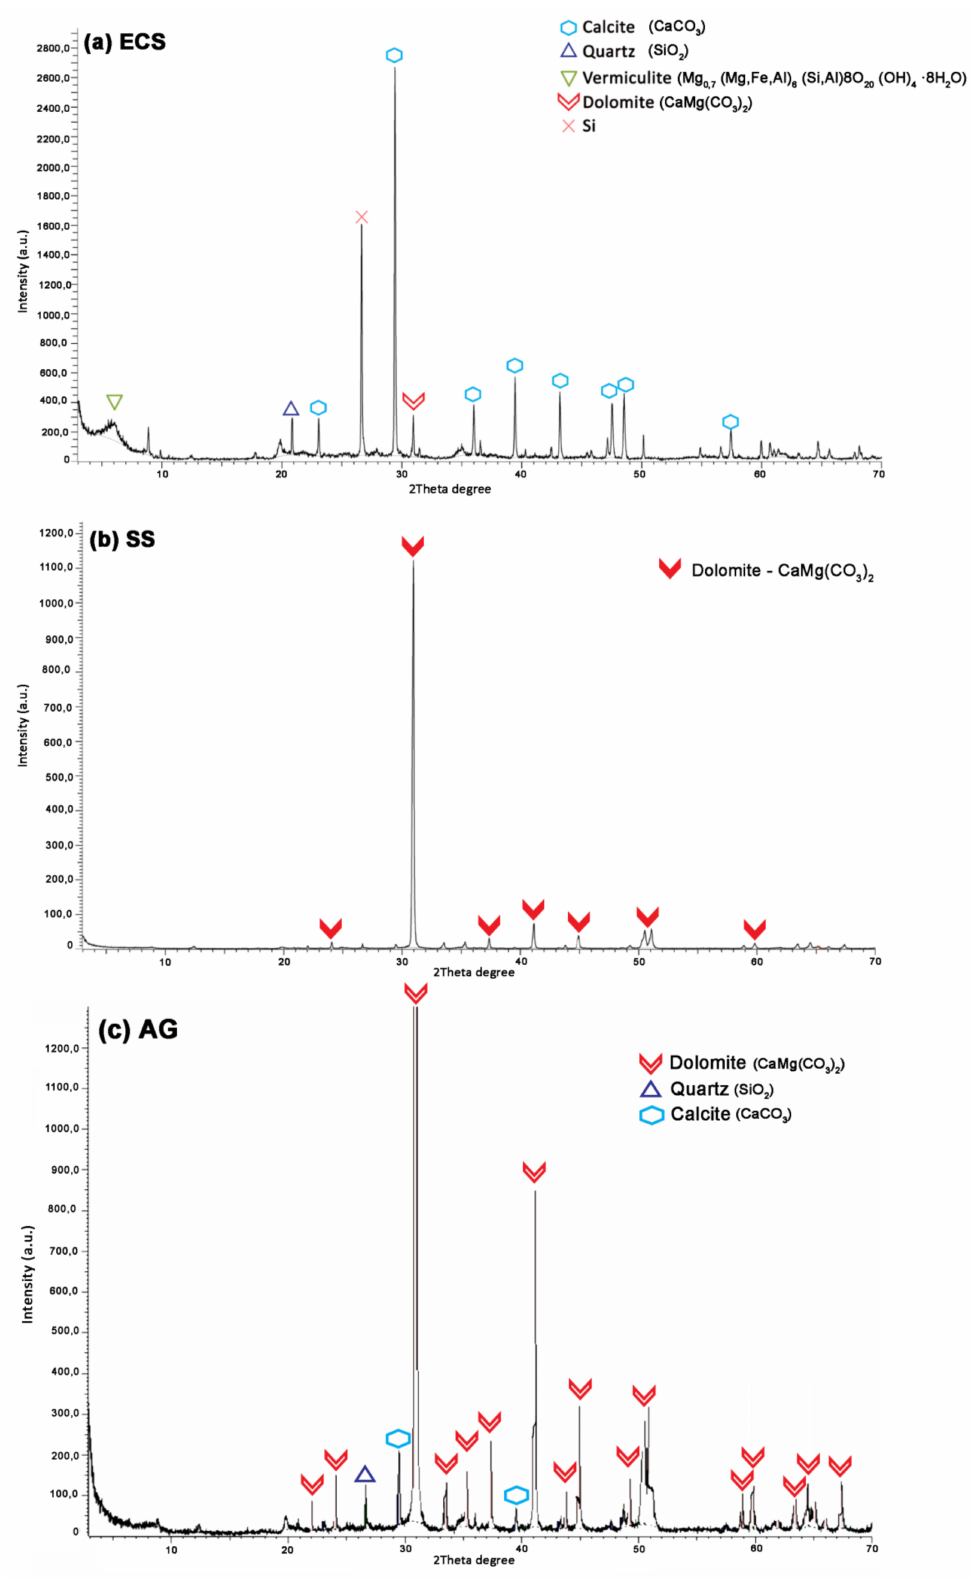
Figure 3. XRD patterns for samples of ( a ) ECS, ( b ) SS, ( c )